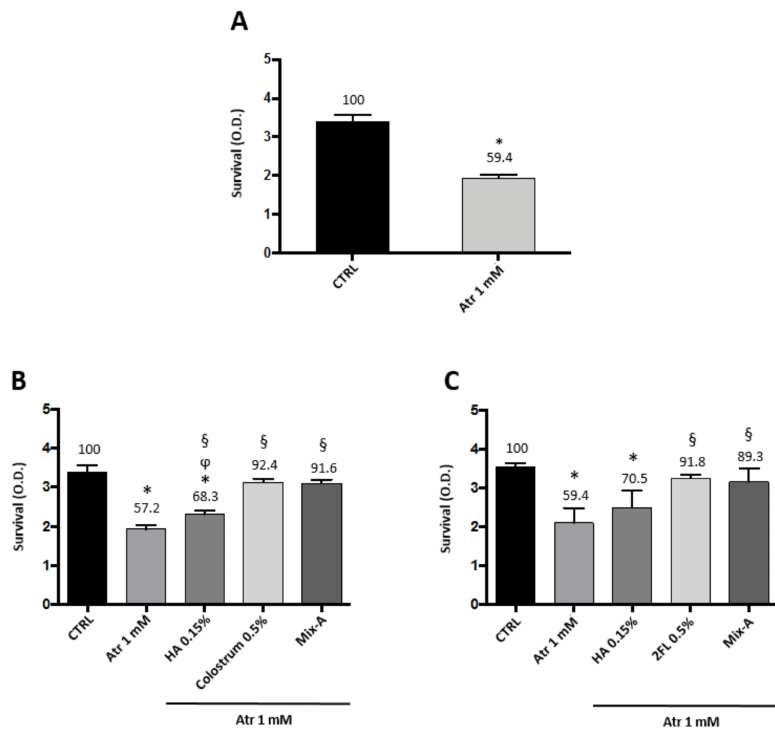
Figure 4. Atropine toxicity on corneal epithelial cells is blunted by colostrum and 2-fucosyl-lactose. HCE-F corneal epithelial cells viability assay in presence of atropine and the protective e ff ects of colostrum or 2-fucosyl-lactose: ( A ) Cell survival after four-day treatment with atropine 1 mM; ( B ) cell survival after four-day treatment with atropine 1 mM in presence of 0.15% HA, 0.5% colostrum, and a combination of 0.15% HA and 0.5% colostrum (Mix-A); and ( C ) cell survival after four-day treatment with atropine 1 mM in presence of 0.15% HA, 0.5% 2-fucosyl-lactose, and a combination of 0.15% HA and 0.5% 2-fucosyl-lactose (Mix-B). Values represent average ± SD of triplicate wells. * p < 0.05 vs. CTRL, § p < 0.05 vs. atropine 1 mM, φ p < 0.05 vs. colostrum 0.5%. One-way ANOVA, followed